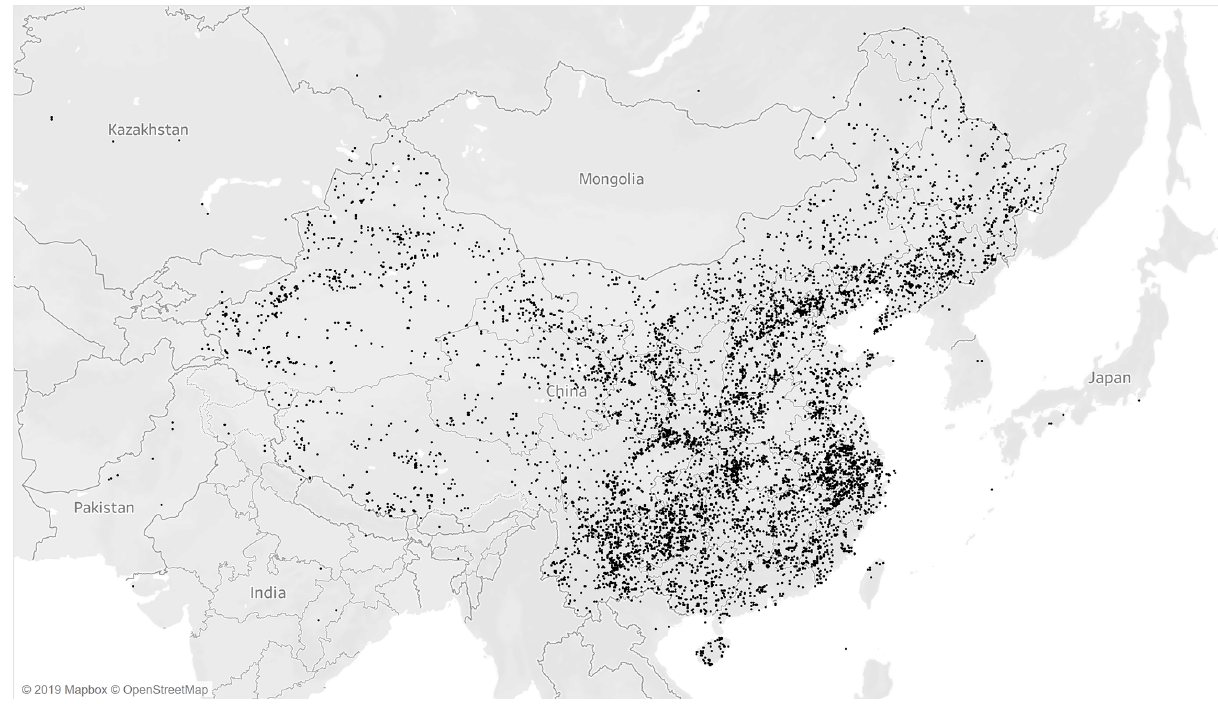
Figure 2. Regional (China–East Asia) distribution of stratigraphic and palaeontological data (2007–2018) of the Geobiodiversity Database (GBDB) (Xu, 2020). Every black dot corresponds to a stratigraphic or palaeontological record of the GBDB. The map is from © Open- StreetMap contributors, 2020. Distributed under a Creative Commons BY-SA